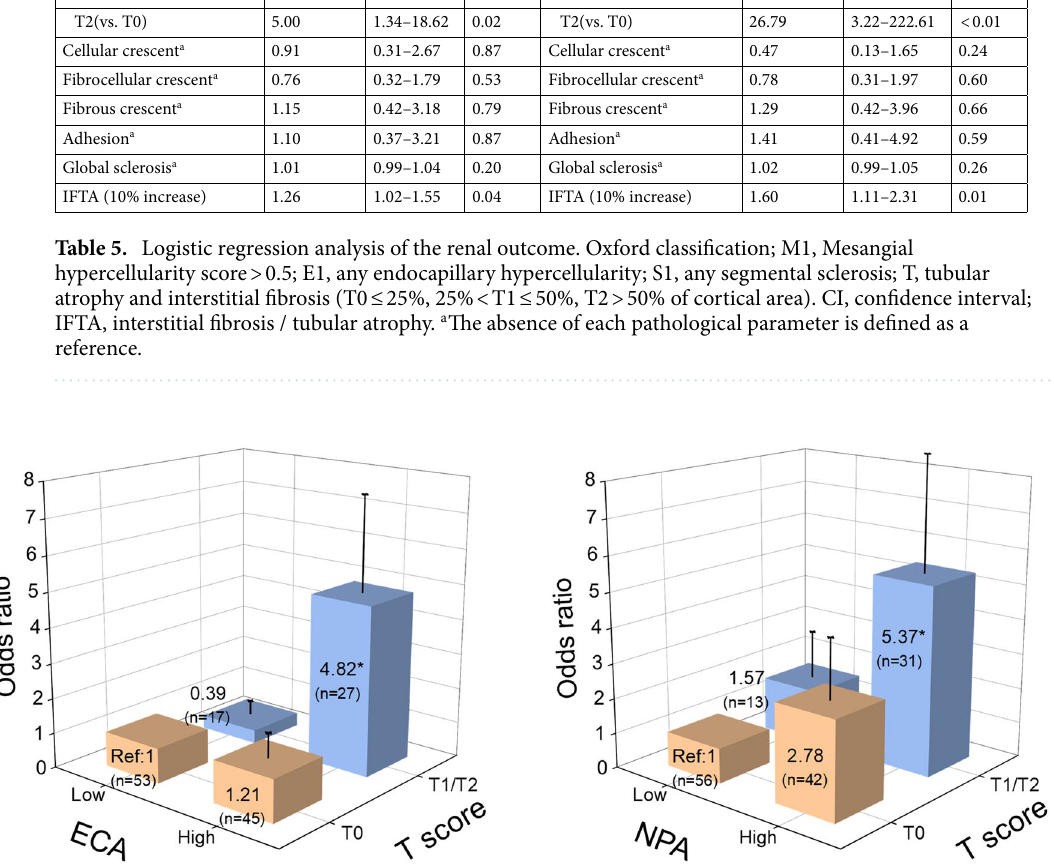
Figure 2. The comparisons of the odds ratios in the groups stratified according to ECA/NPA signals and T score. All patients were divided into four groups by lower or higher median lectin binding signals for ECA, NPA and T score (T0, T1, and T2). The odds ratio for renal outcome was calculated by a logistic regression analysis. The box and neighboring number indicate the odds ratio, and the bar shows the standard error. * P < 0.05 (vs reference group). Abbreviations: ECA, Erythrina cristagalli lectin; NPA, Narcissus pseudonarcissus lectin; Ref, reference. (StataCorp. 2015. Stata Statistical Software: Release 14. College Station, TX: StataCorp